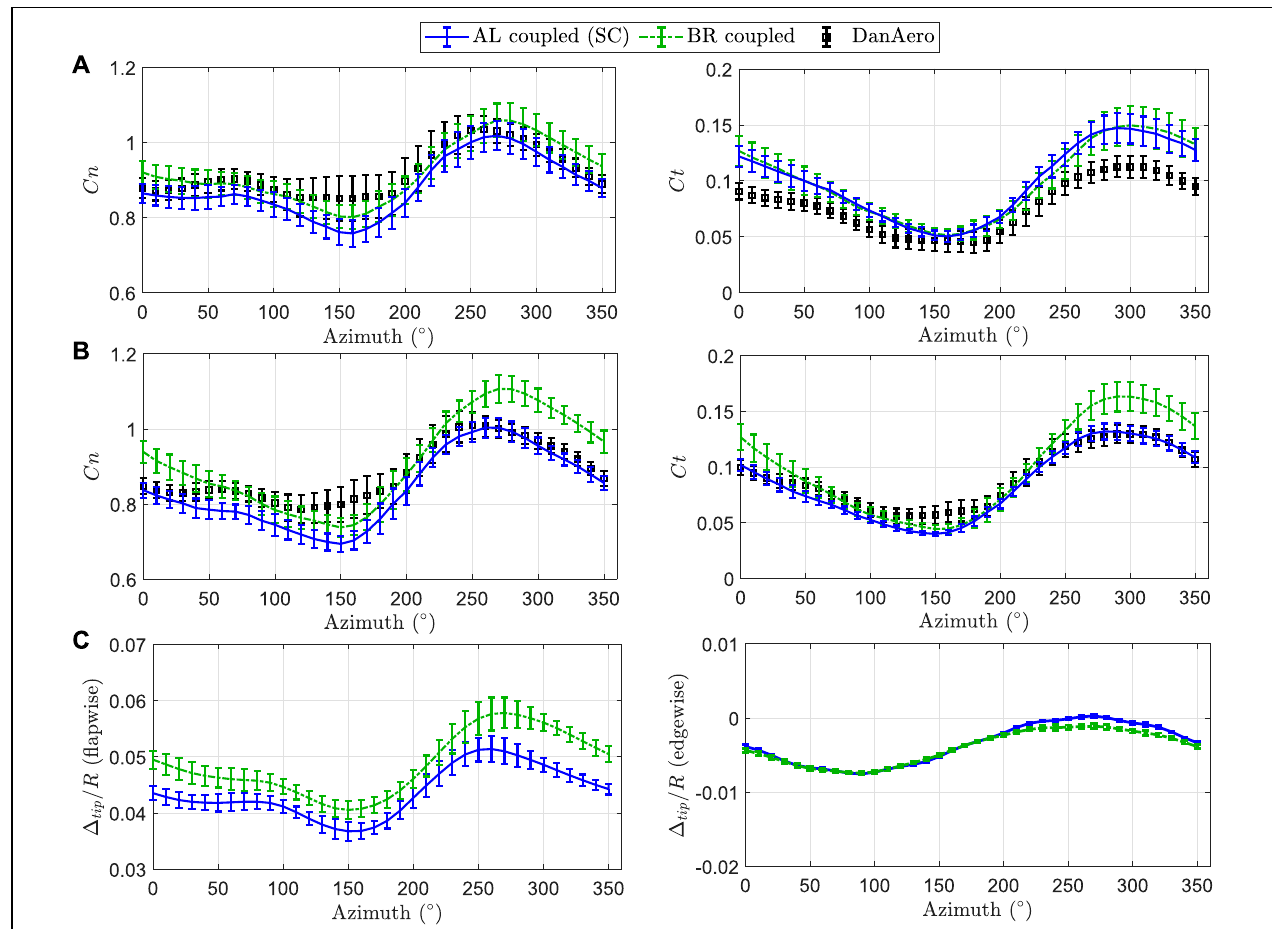
FIGURE 10 | Case 5: high shear, high yaw and turbulence. Note, the standard deviation of DanAero data from Case 3 is added for reference, although the experimental TI does not match the simulated TI. (A) Normalised normal and tangential blade loads at 75% radius; (B) Normalised normal and tangential blade loads at 90% radius; (C) Normalised flapwise and edgewise tip